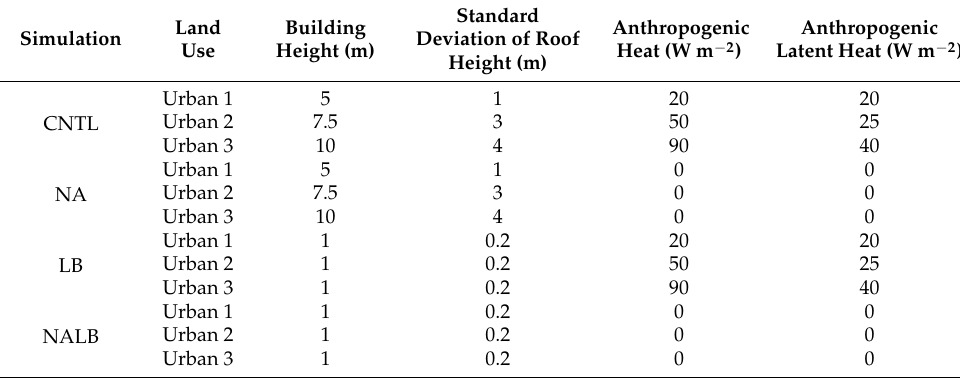
Table 2. Values of urban parameters depending on the urban type used in CNTL and sensitivity simulations. Urban 1, 2, and 3 represent low-intensity residential, high intensity residential, and industrial or commercial,